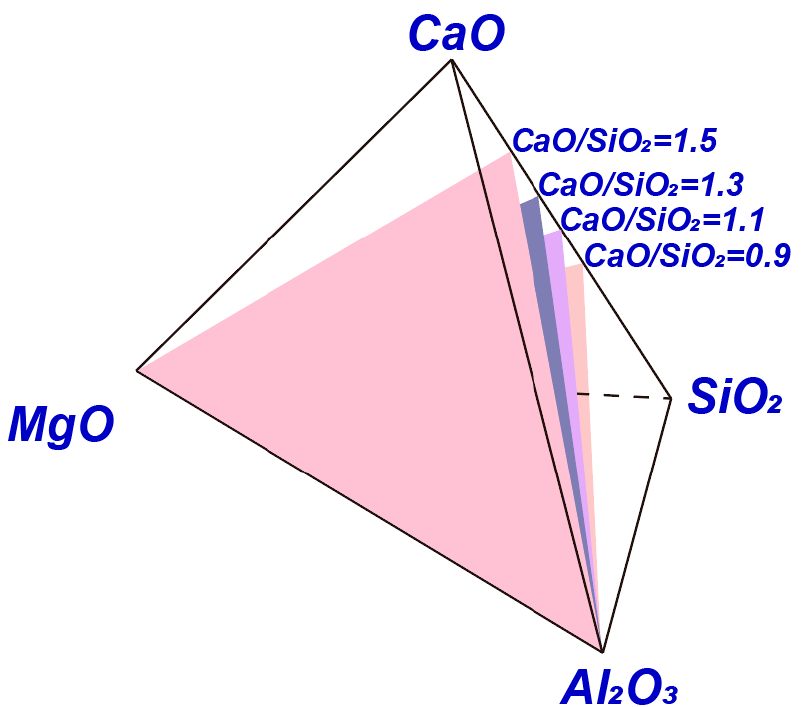
Figure 9. Representation of the pseudo-ternary phase diagrams (CaO + SiO 2 )-Al 2 O 3 -MgO at constant CaO/SiO 2 ratios.